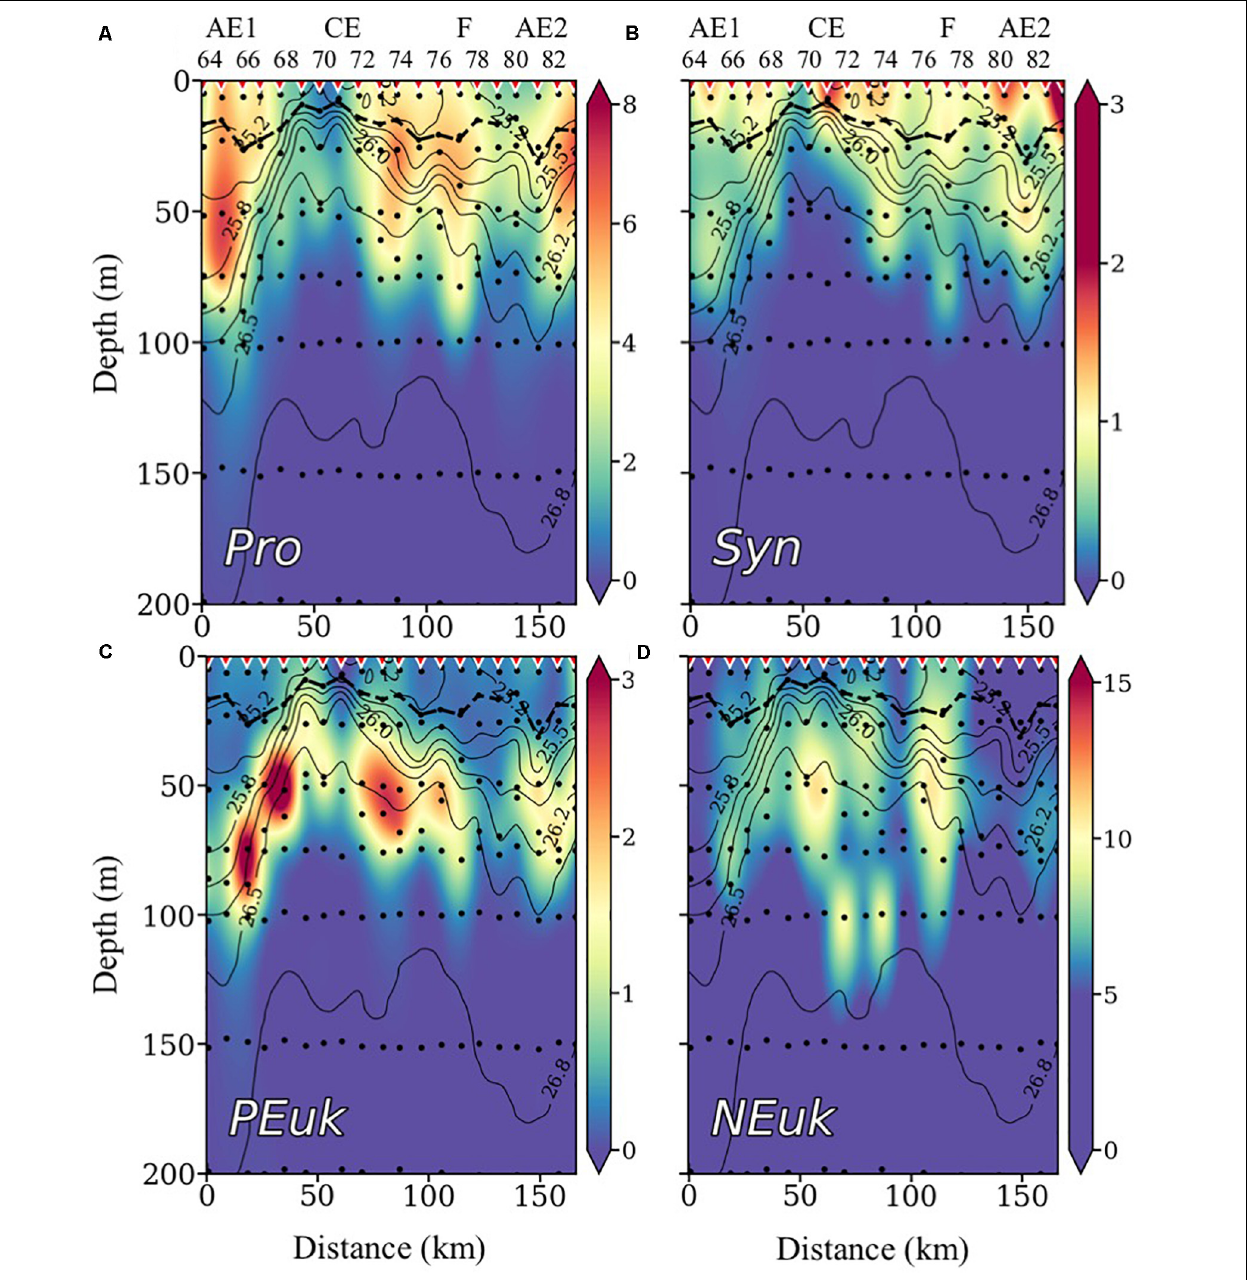
FIGURE 5 | Vertical distribution of cyanobacteria-like Prochlorococcus (Pro) (A) , Synechococcus (Syn) (B) , autotrophic picoeukaryotes (PEuk) (C) , and nanoeukaryotes (NEuk) (D) biomass concentrations in µ g C · m − 3 , with isopycnals superimposed. Inverted red triangles on the top axis indicate stations position. The locations of the anticyclonic eddies (AE), the cyclonic eddy (CE), and the filament (F) are also indicated on the top axis. The bold black line shows the depth of the mixed layer (MLD). Black dots indicate sampled depths. Note the different scales for the plots.